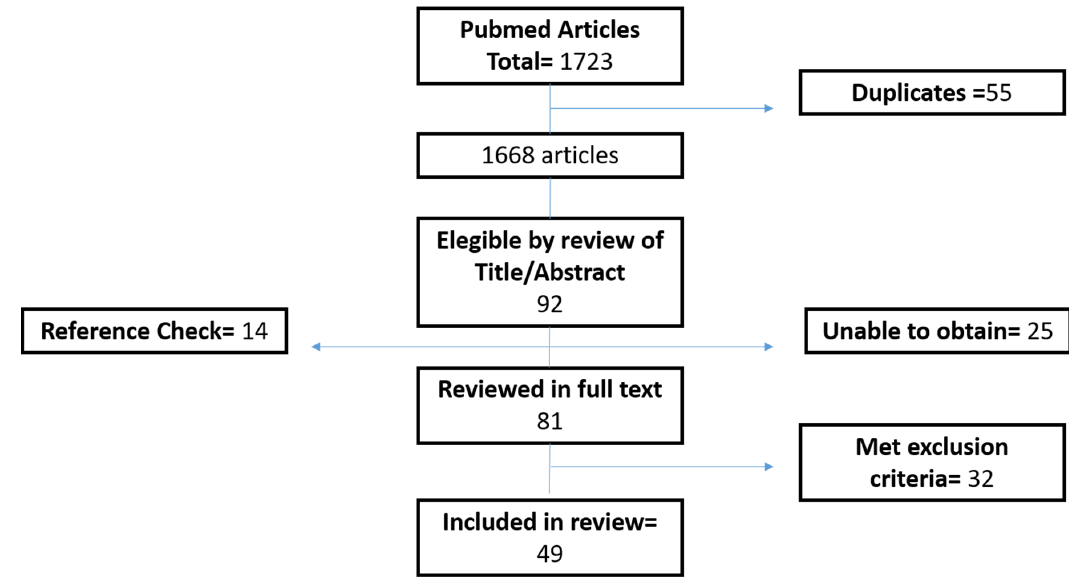
Figure 1. Study flowchart showing the process for the selection of articles to be reviewed.